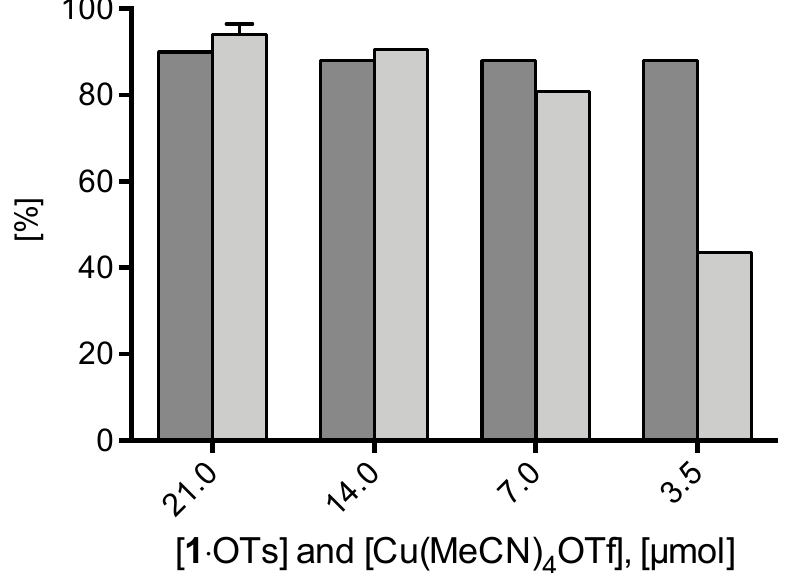
Figure 4. 18 F-Recovery and 18 F-incorporation (RCC) using different amounts of 1 · OTs and Cu(MeCN) 4 OTf. Conditions: [ 18 F]Fluoride (50–200 MBq) was eluted from the respective anion exchange cartridge (see legend of Figure 1) with a solution of a given amount 1 ·OTos in MeOH/DMF (120/500 µL) directly into a solution of equimolar amount of Cu(MeCN) 4 OTf in DMF (600 µL) and the resulting solution was heated at 85 °C for 20 min. The reaction mixture was diluted with H 2 O (2 mL) and RCCs were determined by TLC. All reactions were carried out in the self-made semi-automated